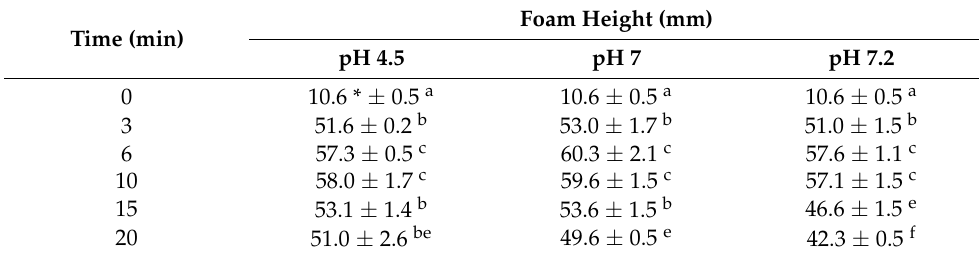
Table 2. Optimum time of foam (OTF) of 3% aqueous egg albumen solution. Time